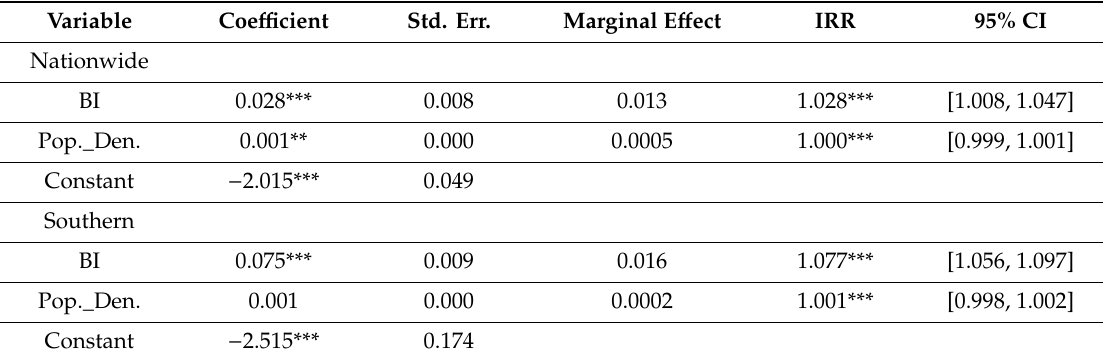
Table 7. Estimation results for the e ff ects of Breteau index and population density on dengue cases.